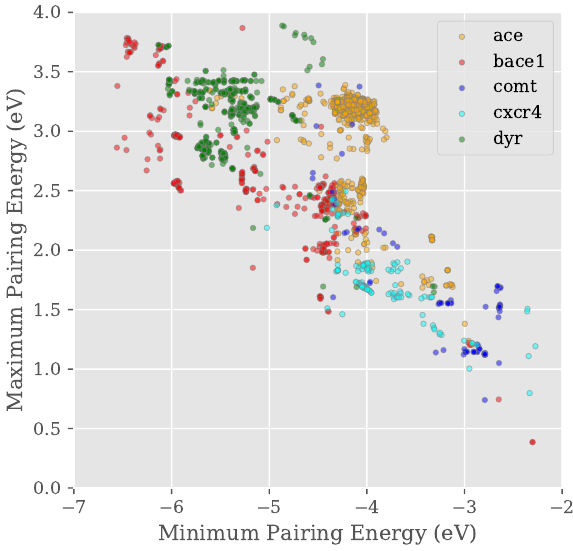
Figure 2. Clustering capacity of pairing-energy descriptors when using the most negative and most positive MPE values for five different DUD-E